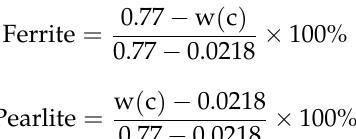
7 of 14 Figure 3. Metallographic pictures of 3 groups of steel: ( a ) 1#; ( b ) 2#; ( c ) 3#. As can be seen from Figure 3, the inclusions in sulfur ‐ type free ‐ cutting steel are mainly distributed in chain shape, the addition of Bi reduces the number of chain inclu ‐ sions, the number of dot inclusions increases, and the distribution of inclusions is uniform. After the compound addition of Bi and Te, the number of cluster inclusions increases, among which the free ‐ cutting steel (in which the environmental protection type of free ‐ cutting element Bi is added alone) has the best distribution. According to the carbon content of the three groups of steels, the low temperature